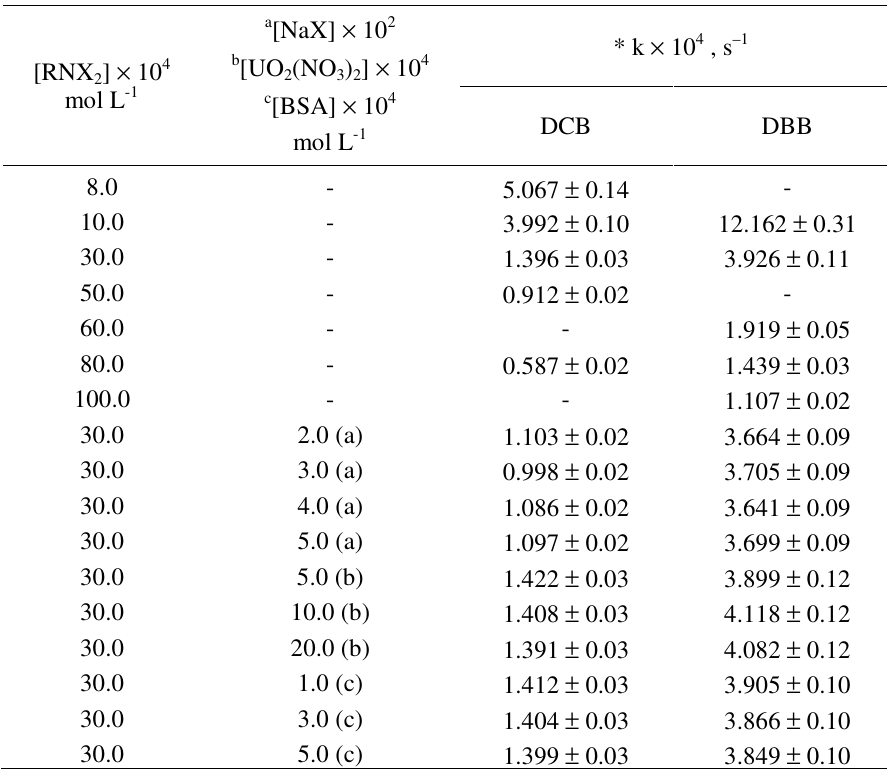
Table 2. Photodecomposition of DCB and DBB in aqueous acetic acid medium at different concentrations